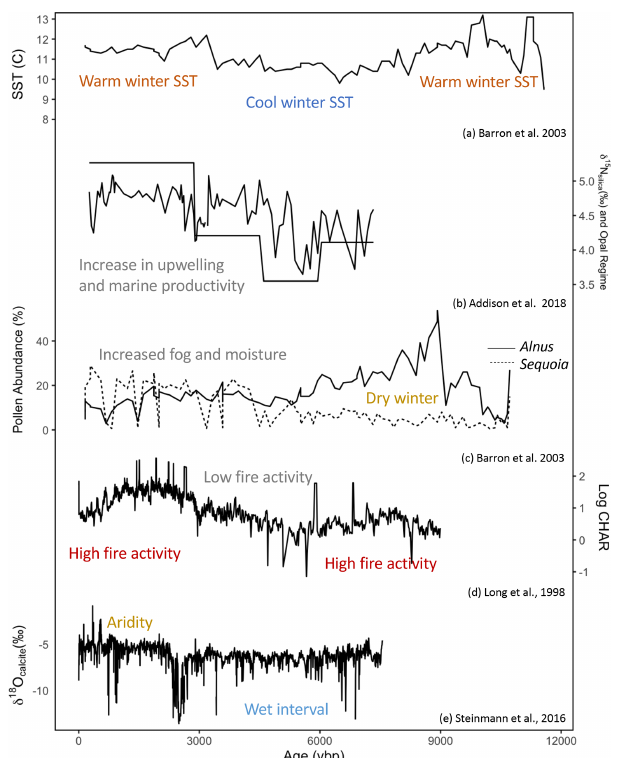
Figure 5. Representative datasets from the Southwest. Oxygen iso- tope record from planktonic foraminifera G. bulloides from Santa Barbara Basin core ODP 893 ( a , Kennett et al., 2007). Pollen as- semblage (%) of Pinus and Sequoia from Central California marine sediment core ( b , McGann 2015). Charcoal influx to Kirman Lake in the Sierra Nevada mountains ( c , Macdonald et al., 2016). Stan- dardized percent clay as a proxy for relative lake status for Silver Lake ( d , Kirby et al., 2015). Diversity of shells from shell midden sites on Channel Islands ( e , Braje et al.,